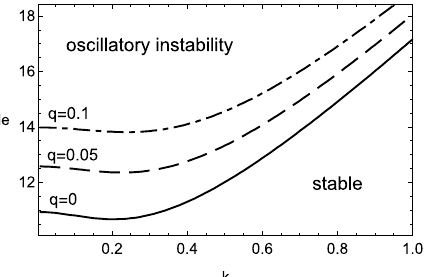
0 (solid line), 0.05 =